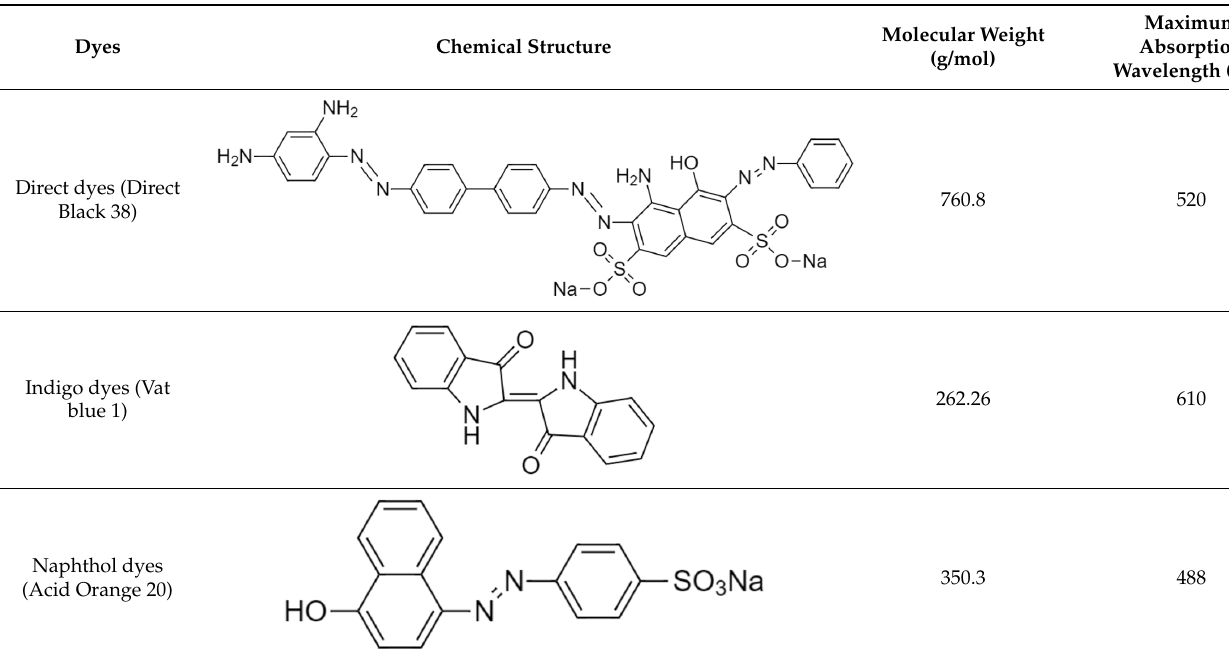
Table 1. Structure of some direct dyes [14].